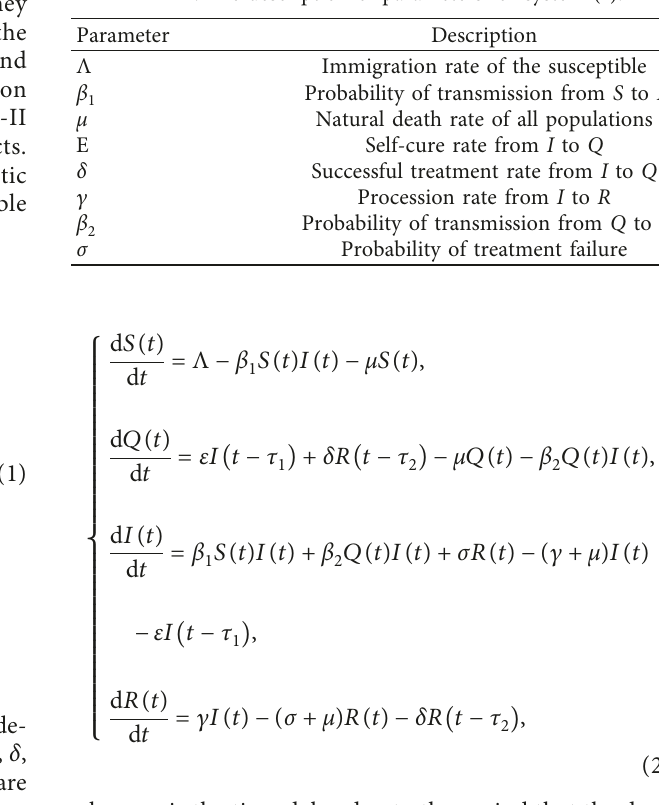
Table 2: The description of parameters for system